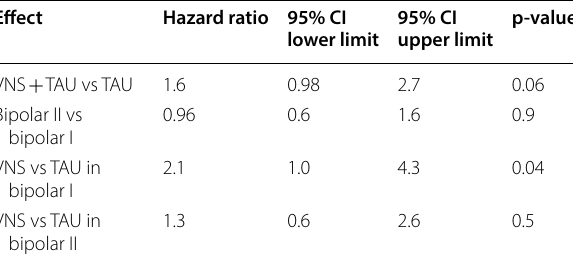
Table 3 Cox proportional-hazards model examining effect of bipolar diagnosis on the time-to-first response Effect